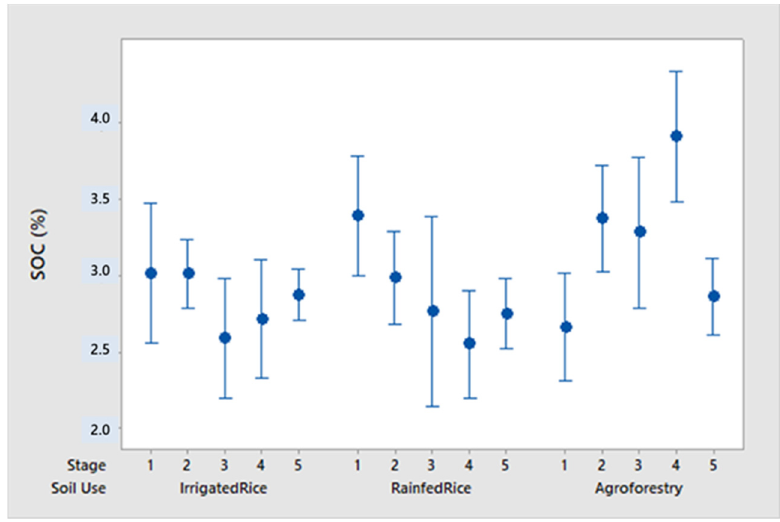
Figure 2. Interaction effect of the soil use and the stage on the soil organic carbon (SOC) ( n = 6).